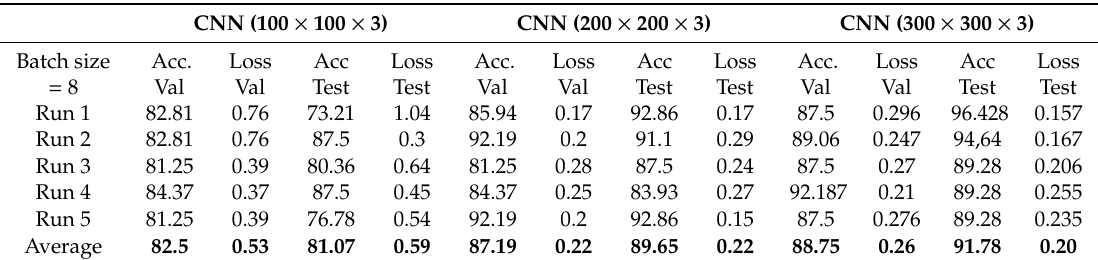
Table A1. CNNs (epochs = 200, dropout = 0.7, conv (8- > 16- > 32), dense = 64) runs for di ff erent pixel sizes.